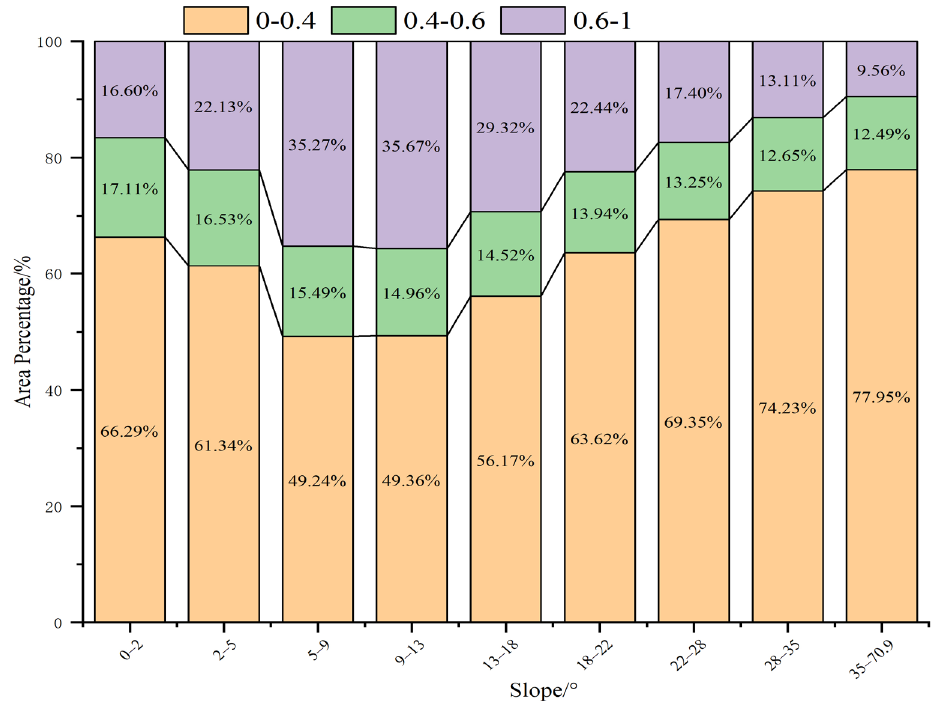
Figure 6. Percentage of FVC on different slopes in the Three North Protection Forest Project area.